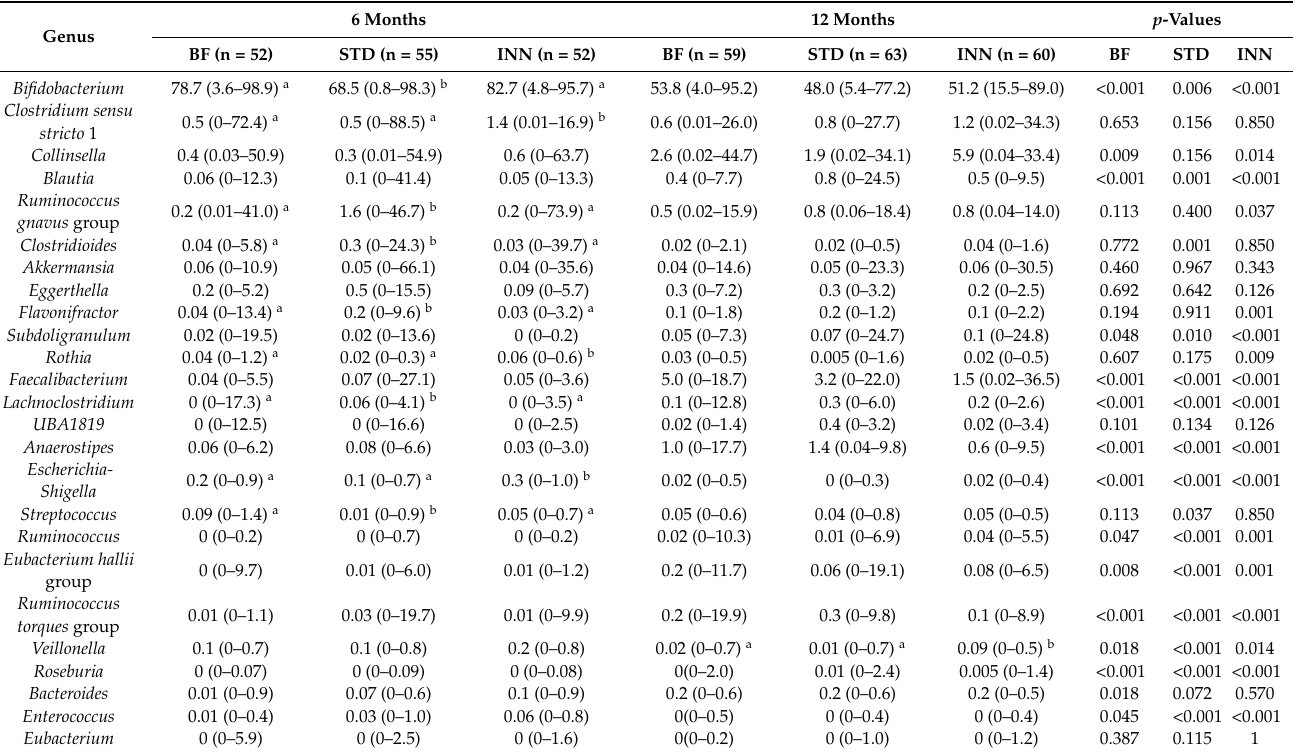
Table 2. The distribution of genera in the INNOVA 2020 study at 6 and 12 months of infant’s